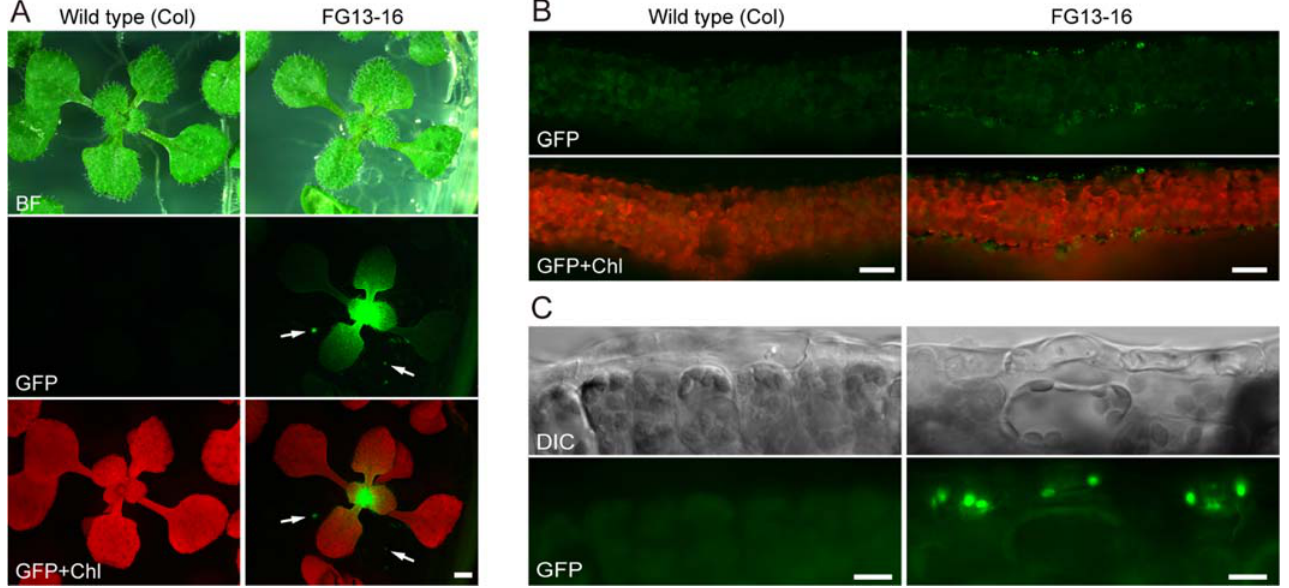
Figure 3. Fluorescence stereomicroscopy and epifluorescence microscopy analyses of 2-week-old wild-type (Col) and PDF1 p:: TP SIG6 -GFP transgenic (FG13-16) Arabidopsis seedlings grown on Murashige and Skoog (MS) medium. ( A ) Plant growth. Arrows indicate the local accumulation of GFP in transgenic roots. ( B , C ) Cross-sections of leaves. DIC, GFP, or chlorophyll autofluorescence (Chl) images or the merged GFP and Chl images are shown at low ( B ) and high magnification ( C ). Bar = 1 mm ( A ), 50 µm ( B ), and 10 µm ( C ).